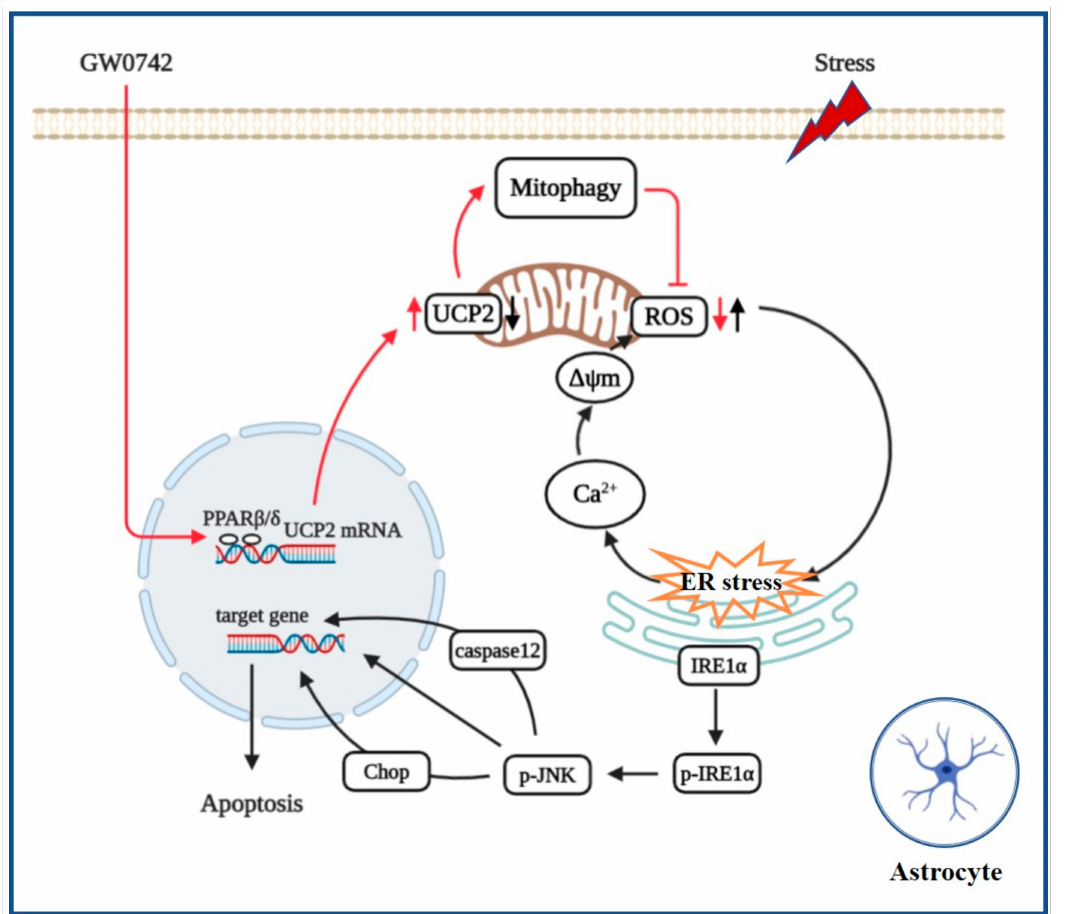
Figure 7. PPAR β / δ agonist protects against oxidative stress and ER stress-induced astrocytic apoptosis by inhibiting the phosphorylation of IRE1 α , which are due to enhancing UCP2-dependent